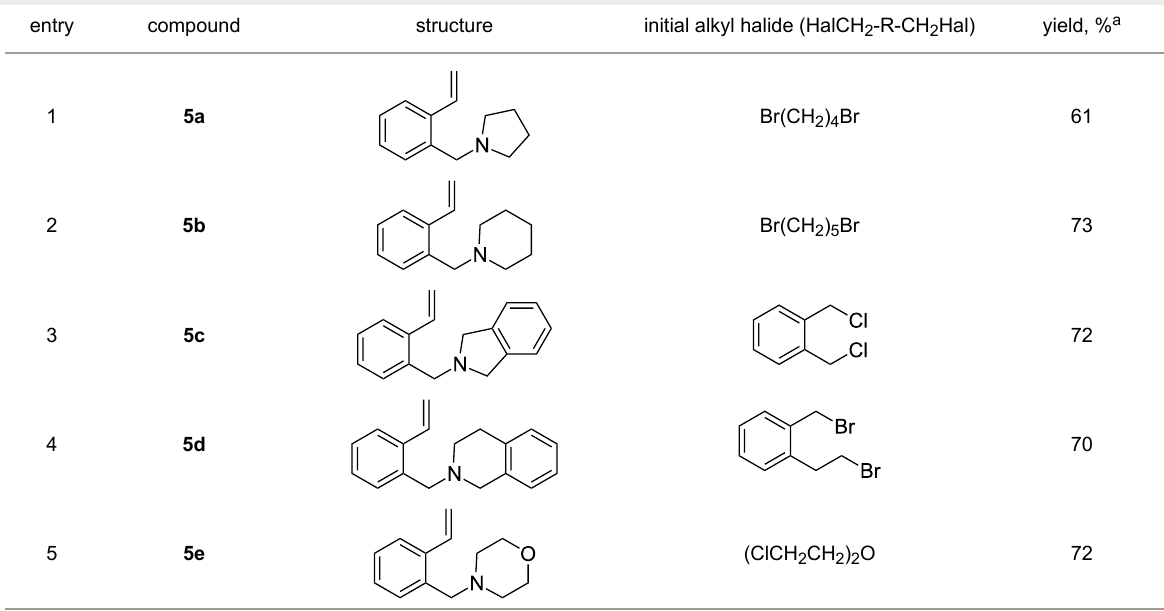
Table 2: Structure and yields of N -(2-vinylbenzyl)heterocycles 5